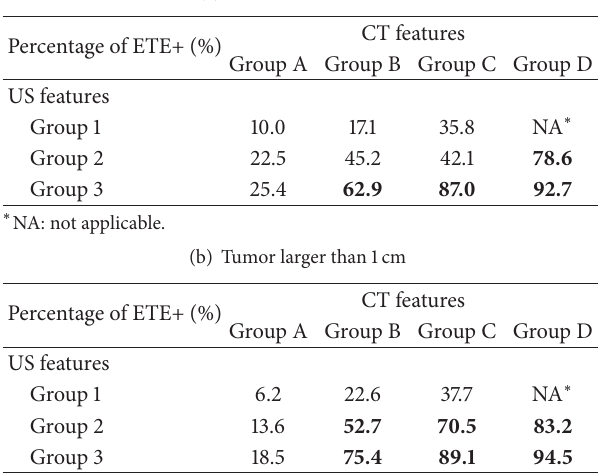
Table 4: Positive predictive value of combining of US and CT according to tumor